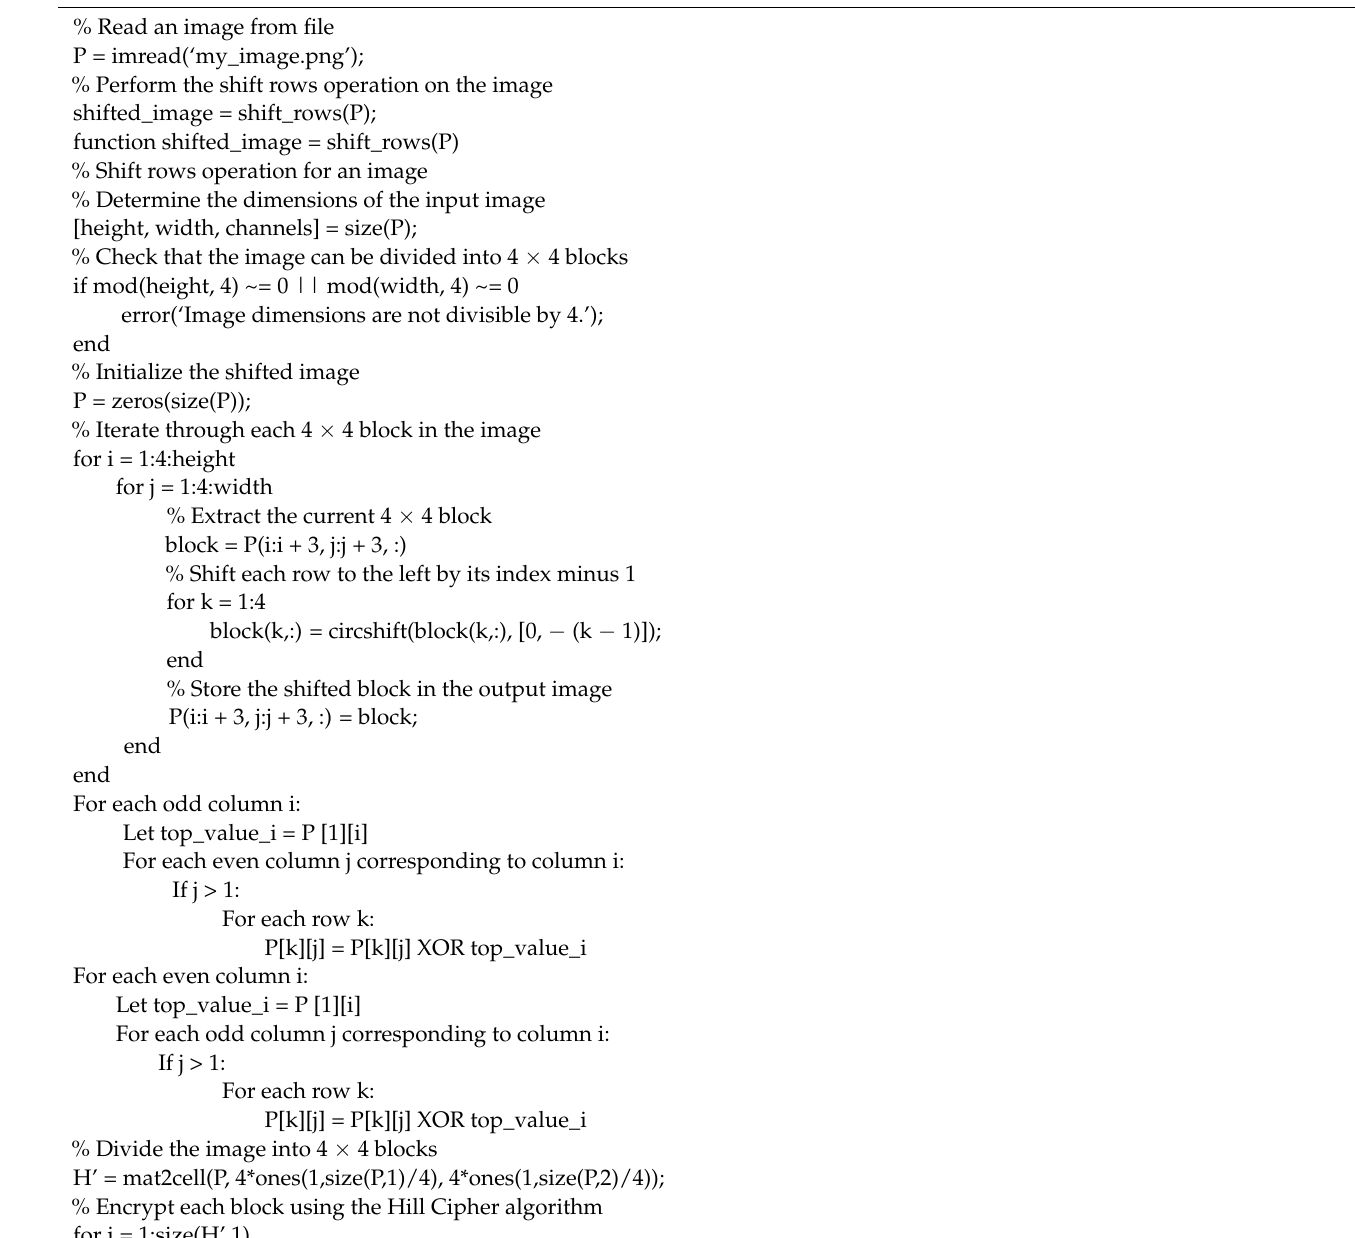
Algorithm A1. Encryption